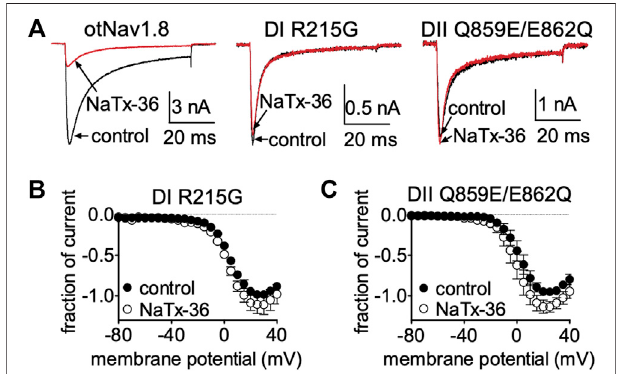
FIGURE 9| Effects ofNaTx36 on DI S4 voltage sensor and DII SS2 – S6 pore loop mutants. (A) Representative Na + current traces were elicited by a 50-ms depolarization to +20 mV from a holding potential of − 80 mV before andafterapplicationofNaTx36toND7/23cellstransfectedwitheitherDI or DII mutant OtNav1.8. (B,C) To determine the fraction of current after toxin treatment, Na + currents were elicited by 50-ms depolarizing steps to various voltages ranging from − 80 to +40 mV in 5-mV increments. All Na + currents were normalized to the maximum amplitude of control peak current. (B) NaTx36 (100 nM) did not inhibit the OtNa V 1.8 DI voltage sensor S4 R215G mutant (control, n = 3; NaTx36, n = 3; p = 0.23). (C) In addition, NaTx36 (100 nM) had no effect on the DII SS2 – S6 pore loop Q859E/E862Q mutant (control, n = 5; NaTx36, n = 5; p =0.08). All cells were pretreated with 500 nM TTX to block TTX-sensitive sodium channels.